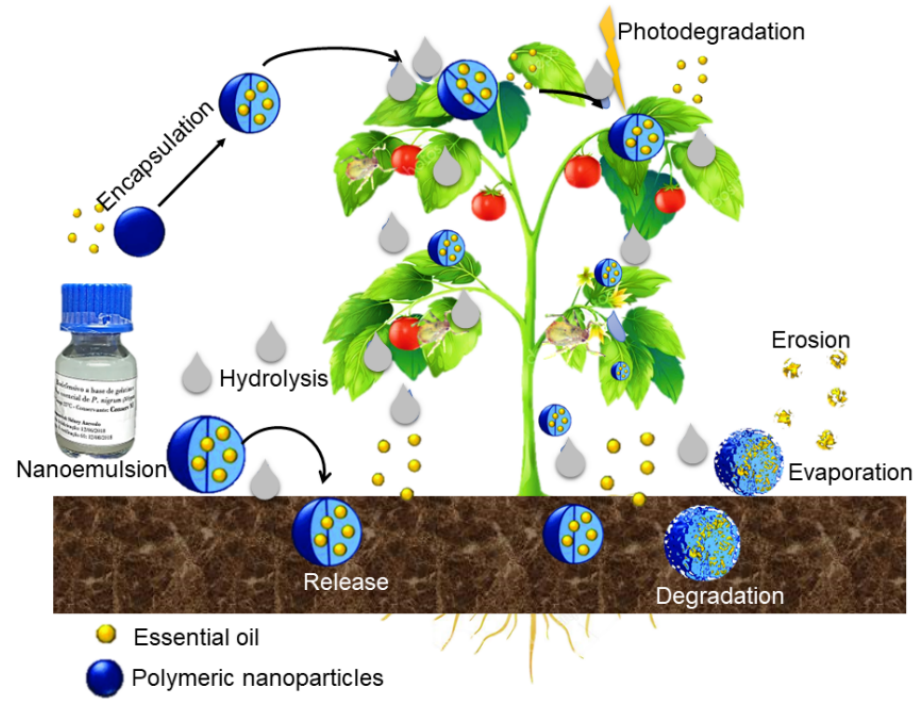
Figure 1. Scheme of the controlled release of essential oil and the degradation of polymeric nanoparticles. The nanosystem comprises the active ingredient encapsulated by a biodegradable polymer. Controlled release occurs due to the degradation of the polymer. When the polymer interacts with the environment in which the release takes place, there is a breakdown of the wall material, which can be due to thermal degradation or photodegradation, and then the release of the active ingredient occurs.